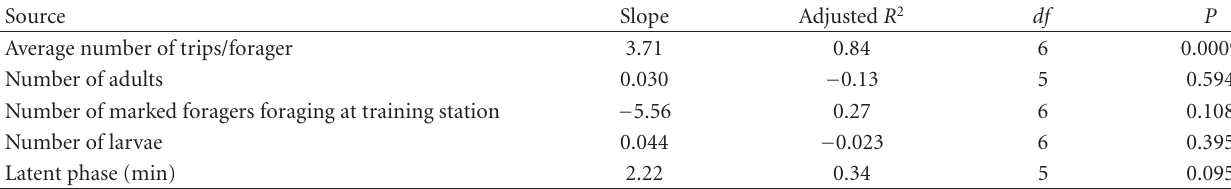
Table 3: The relationship between the total number of arrivals to the training station and the average number of foraging trips/forager to the training station, the number of adults in colony, the number of marked foragers foraging at the training station, the number of larvae in the colony, and the duration of the latent phase, using a simple regression analysis.